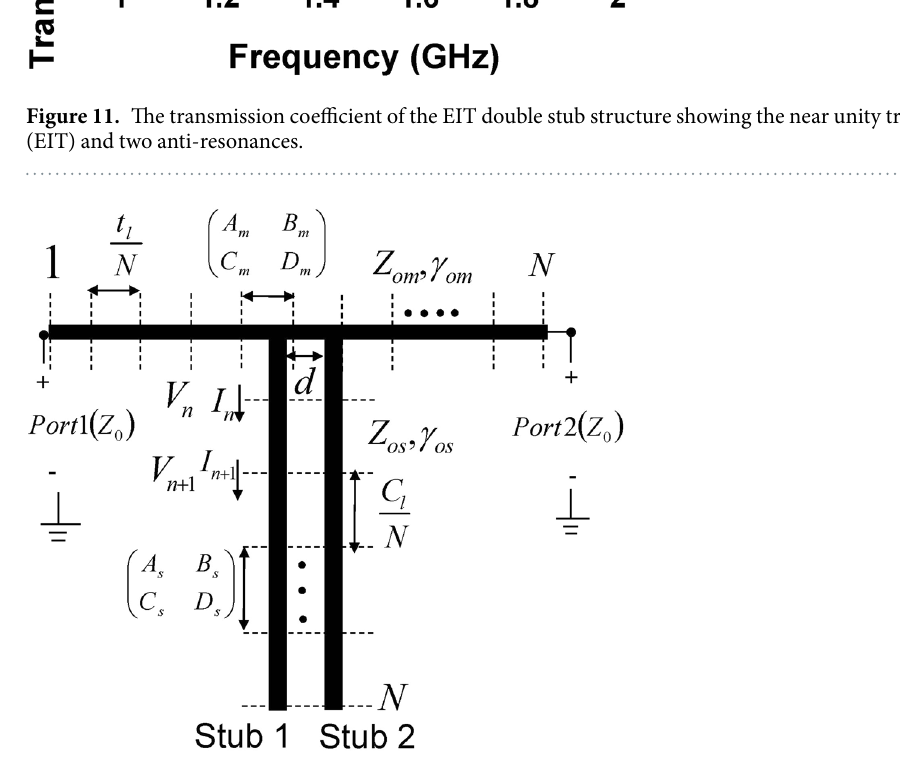
Figure 12. The illustration of the analytical method to calculate the current distribution on the double stub